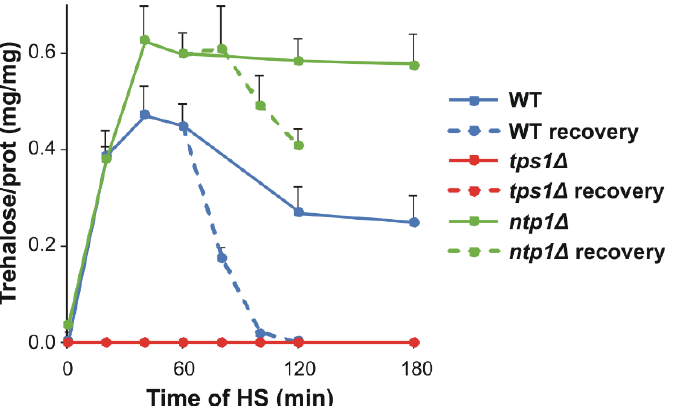
Figure 2. Kinetics of heat-induced trehalose accumulation. Yeast cells were heat-stressed at 40 °C for 0–180 min or, after 60 min of stress, were left to recover at 30 °C for 60 min. Data are presented as mean ± SD, n = 3 (independent experiments); for significance values, see Table S2. WT, wild-type; tps1 Δ , trehalose-deficient; ntp1 Δ , trehalase-deficient S. pombe strains.